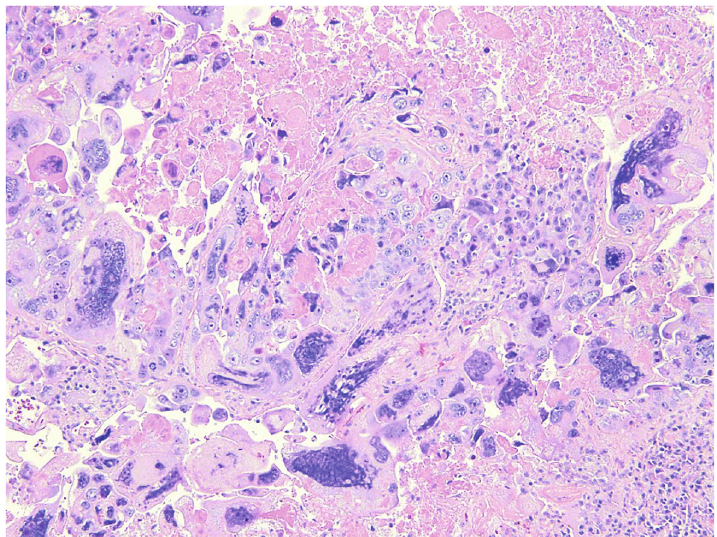
Figure 1: Hematoxylin and eosin stain and pleomorphic lung carcinoma (10x magni fi